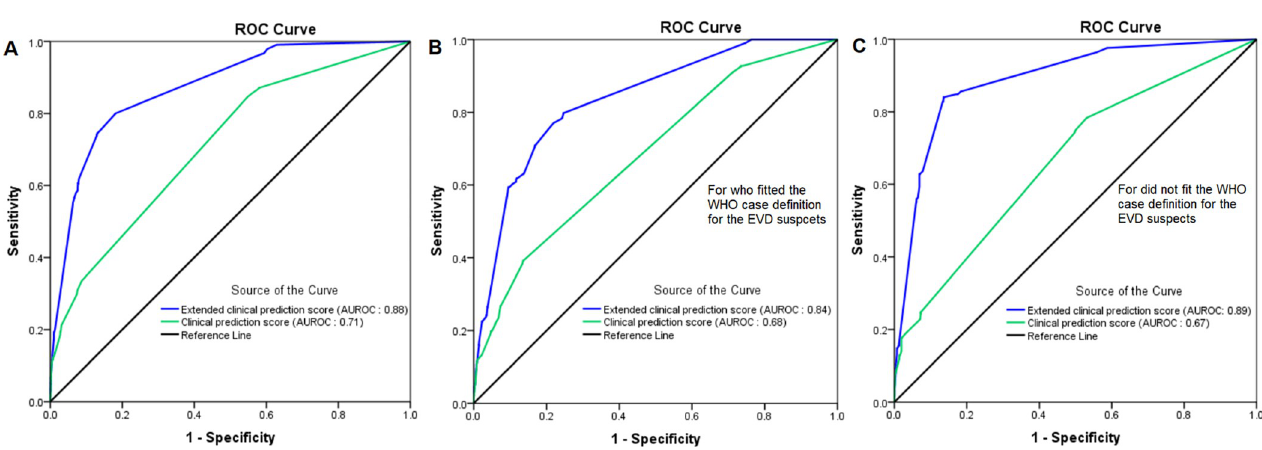
Fig 3. Receiver operating curves (ROCs) plotting the discriminatory performance of the clinical prediction and extended clinical prediction scores for the screening of EVD. (A) depicts the ROCs for the overall set of EVD suspects, (B) the ROCs for the set of EVD suspects who fit, and (C) presents the ROCs for the set of EVD suspects who do not fit with the WHO case definition